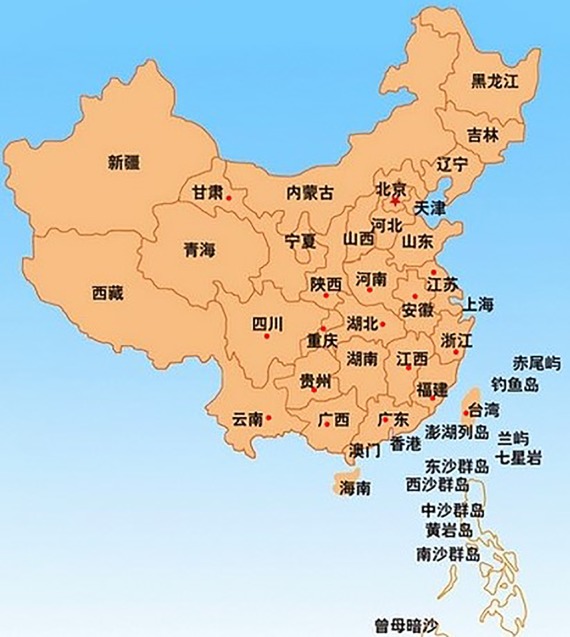
The red spots in the map depicted the main region of A. chinensis distribution in China (Flora of China, 2007; https://www.newasp.net/soft/105257.html).